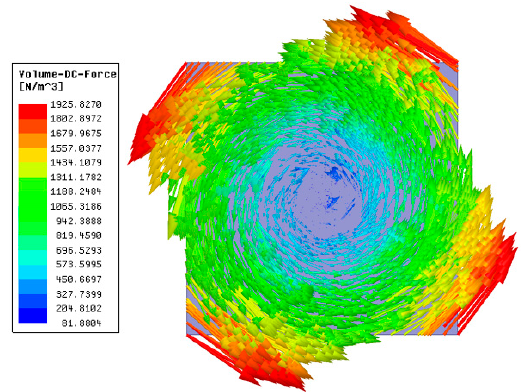
Figure 8. Vector of time-averaged electromagnetic force density on the strand section Z = 0.54 m at 500 A/3 Hz.